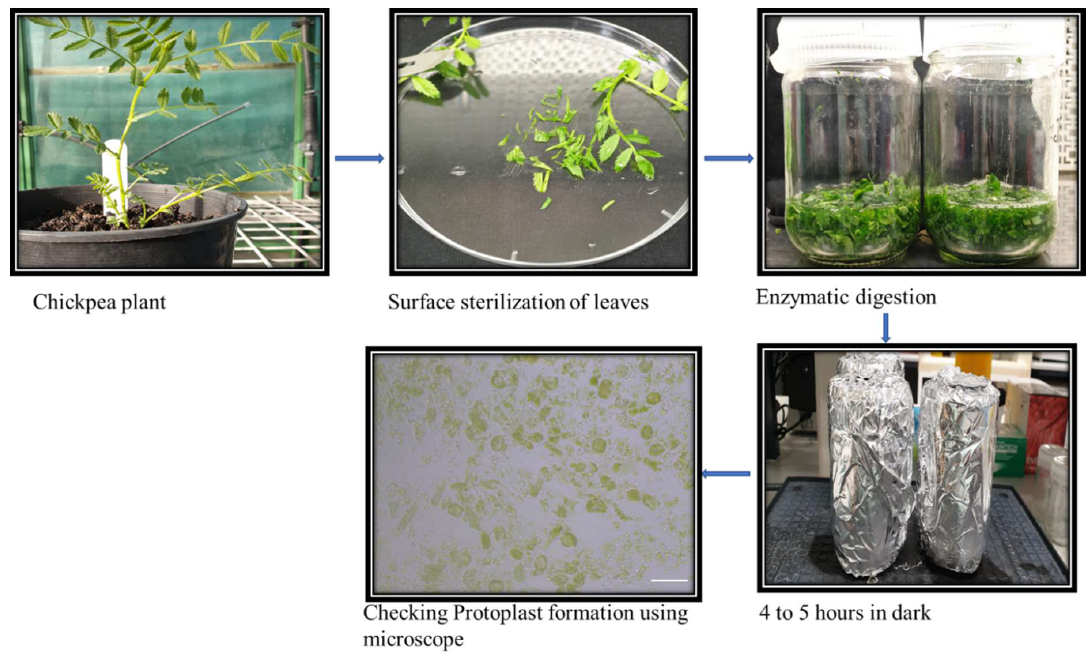
Figure 4. Flow chart of the steps performed during the protoplast isolation from leaf tissue of chickpea plants. The leaves from the 4 to 5 weeks old plants were collected and surface sterilized. The leaves were cut into small pieces. The enzyme solution was prepared and cut leaf sections were kept in the dark for 4 to 5 h digestion resulting in protoplast formation. After 2 h, samples for protoplast formation were collected to check the protoplast formation stage, and once the protoplast were isolated, they were used for the PEG mediated transfections.